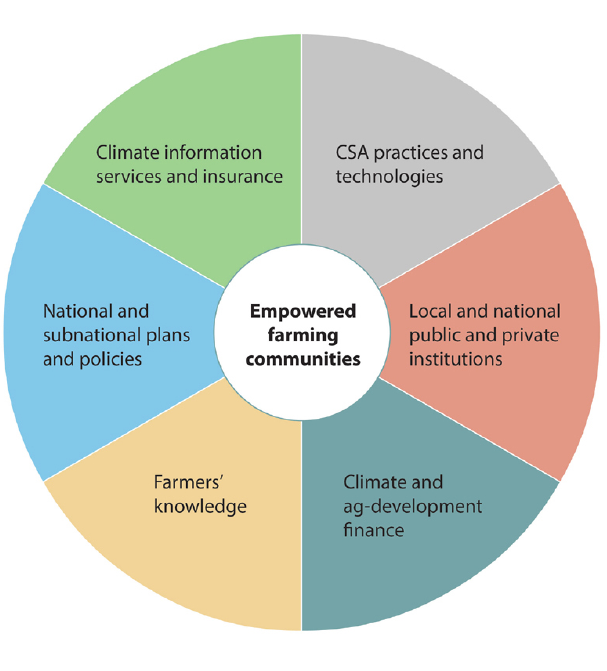
Fig. 1. Key components of a CSV AR4D